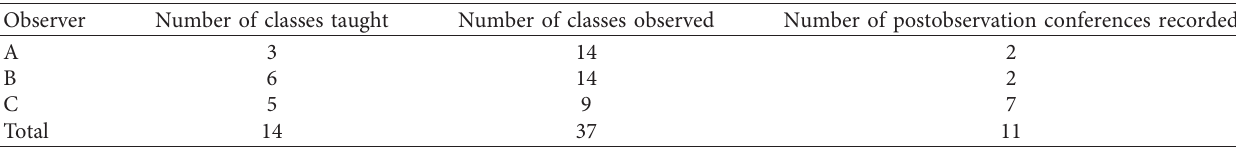
Table 2: Statistical information about observers’ classes and postobservation conferences.